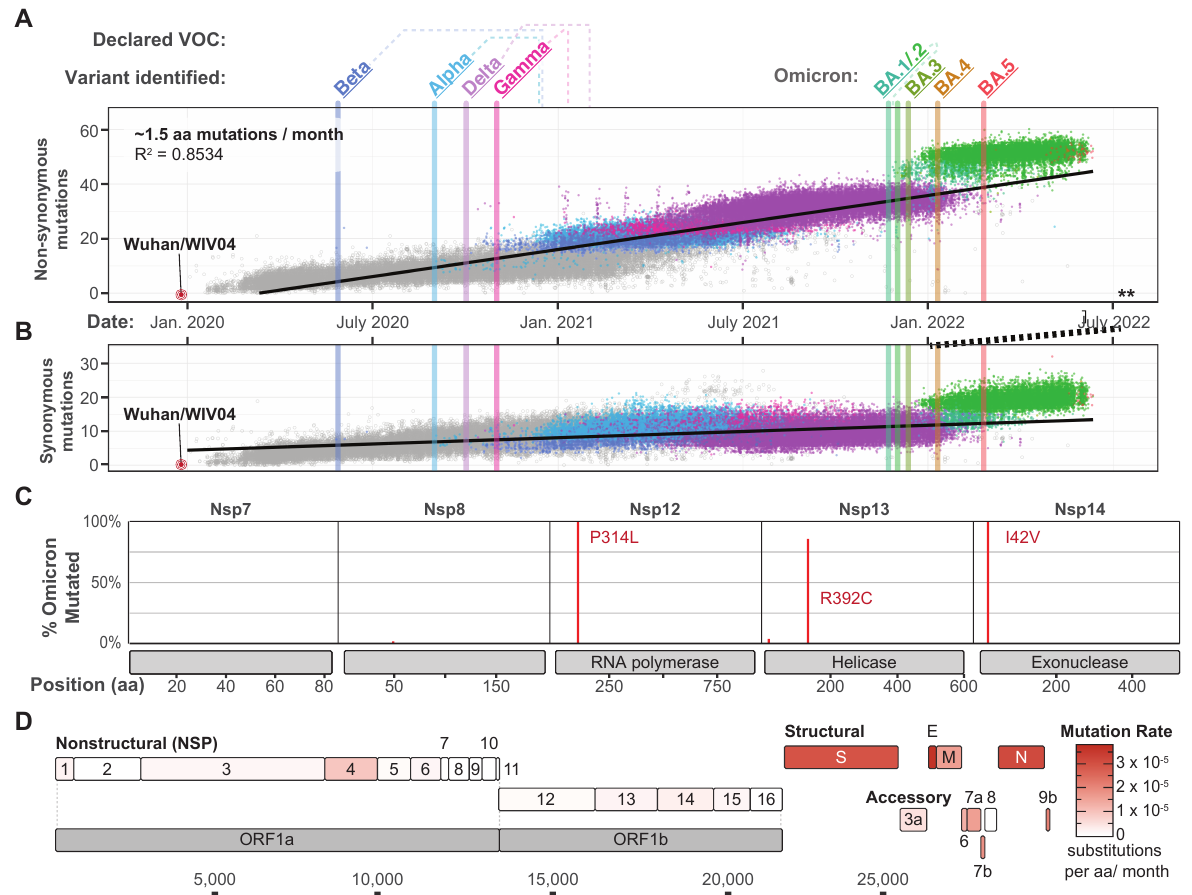
Figure 2. ( A ) Non-synonymous mutations acquired over time in 26 SARS-CoV-2 protein sequences extracted from 97,437 genomes from 19 December 2021, to 17 June 2022 (GISAID accessions available at: https://github.com/WiedenheftLab/Omicron (accessed on 18 July 2022) and DOI: https://doi. random sampling of 11,336,176 million SARS-CoV-2 from GISAID, which were quality filtered using NextClade (“good” overall QC status) then sampled with the Filter utility in NextStrain (selecting up to 120 genome per country per month of the pandemic) [1,14]. Variants of concern (VOC) are shown in bold and are colored as in Figure 1. Vertical lines mark the date the first sequence for each lineage was identified. The time elapsed between first detection and VOC designation by the WHO is shown as dotted lines above the graph. Dots are colored similar to variant names, and grey circles represent non-VOC lineage genomes. A linear regression line is shown in black. Omicron variants deviate from the trend. ( B ) Synonymous mutations in the SARS-CoV-2 genomes shown in panel ( A ). ( C ) Non-synonymous mutations in the Omicron RNA replication proteins ( n = 13,094 genomes) are shown as red lines on schematic representations of each protein, and frequencies of each mutation shown as vertical lines (red). Most non-synonymous mutations are found in less than 1% of Omicron sequences. ( D ) Schematic depiction of SARS-CoV-2 protein coding sequences, with each gene colored according to its respective amino acid mutation rate. These rates are normalized to account for the length of each protein (i.e., substitutions/amino acids in protein/month of the pandemic). Based on the anomalous mutational profiles of Omicron viruses, we hypothesized that Omicron genomes have mutations that affect the fidelity of viral RNA replication machinery. To test this hypothesis, we analyzed the sequences of replication-associated proteins